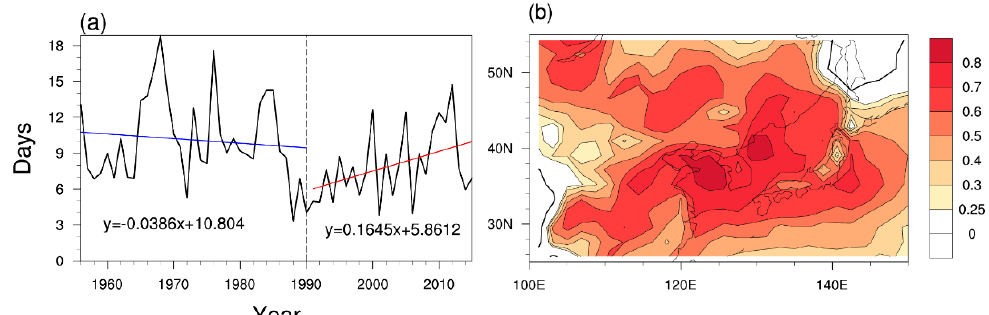
Figure 4. ( a ) Time series of NCD index (Black) during 1956–2015. Blue and Red lines refer to linear trend of NCD during 1956–1990 and 1991–2015, respectively; ( b ) map of correlation coefficients between NCD index and the NCD at each grid point in winter over East Asia during 1956–2015. Shaded values are significant, exceeding 95% confidence level based on Student’s t -test.